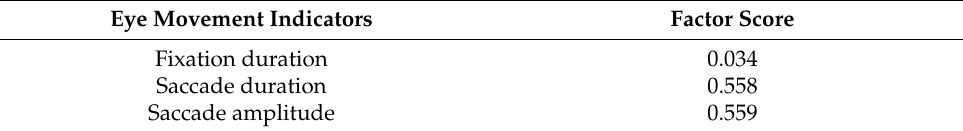
Table 7. Factor score coefficient.